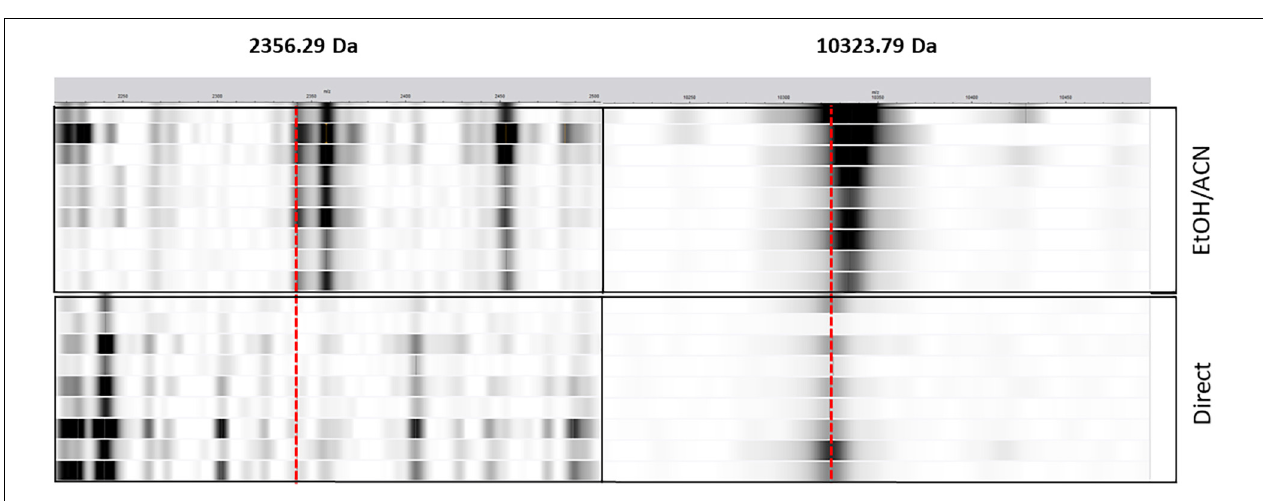
FIGURE 6 | Pseudogel view representation of mass spectra from C. coli from the direct deposit (direct, n = 8) and the ethanol/acetonitrile off-plate extraction (EtOH/ACN, n = 8). The x -axis represents the mass-to-charge (m/z) ratio in Da. Strips intensities is function of the peak intensity. The red dashed lines represent the observed peaks, i.e., 2,356.29 and 10,323.79